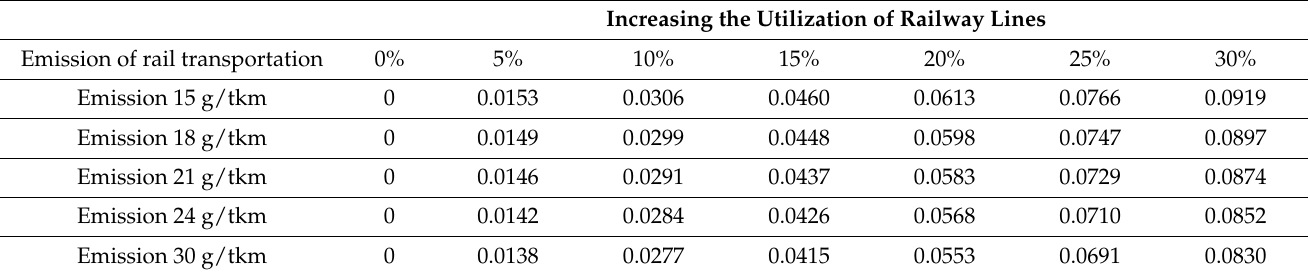
Table 4. Emissivity reduced by an increase in the utilisation of the railway line [t CO 2 ]. Increasing the Utilization of Railway